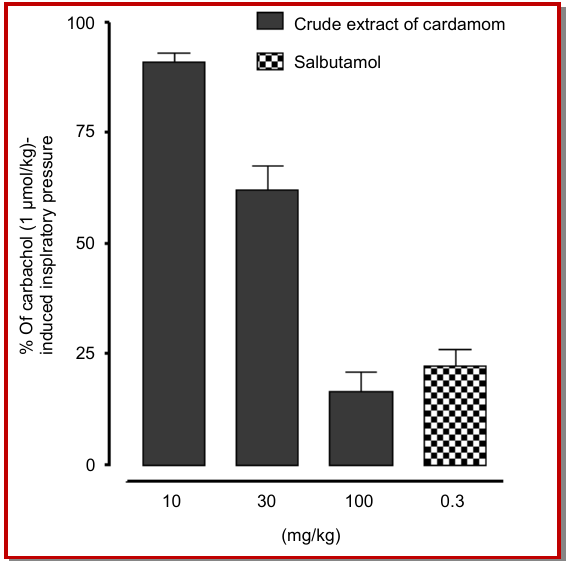
Figure 1: Bar-chart showing inhibitory effect of the crude extract of cardamom and salbutamol on the carbachol-mediated bronchoconstriction in anesthetized rats. Values shown are mean ± SEM, n= 4